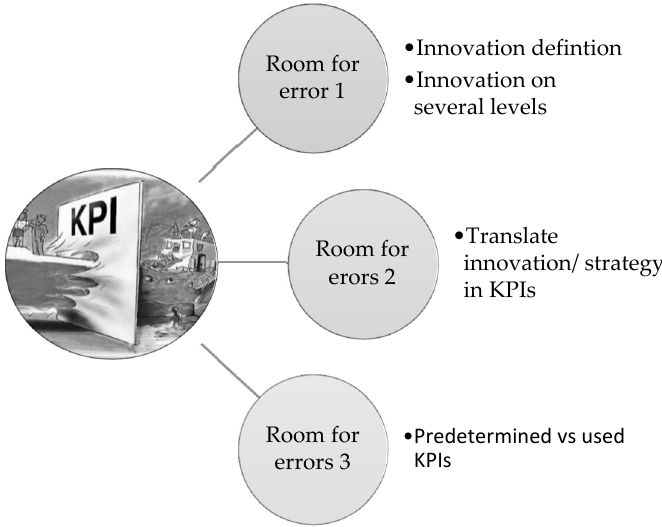
Figure 1. Summary of room for organizational errors in innovation KPIs.